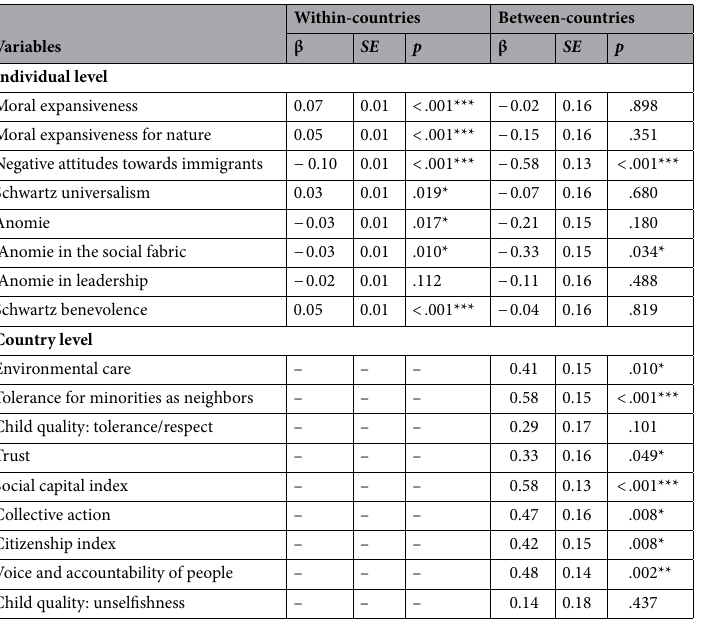
Table 3. Relationship between social mindfulness and more complex forms of cooperative attitudes and outcomes. * p < .05, ** p < .003^, *** p < .001. Each variable was analyzed in a separate Linear Mixed Model with age, gender, economic conservatism, and social conservatism included as controls. ^Bonferroni corrected alpha